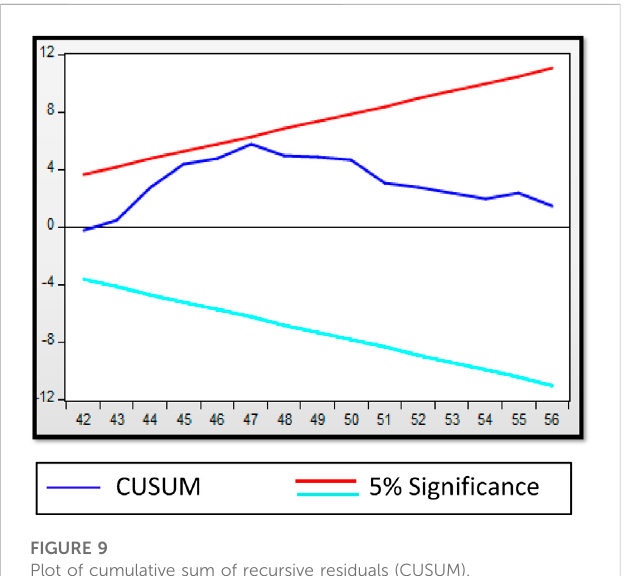
FIGURE 10 Plot of cumulative sum of squares of recursive residuals